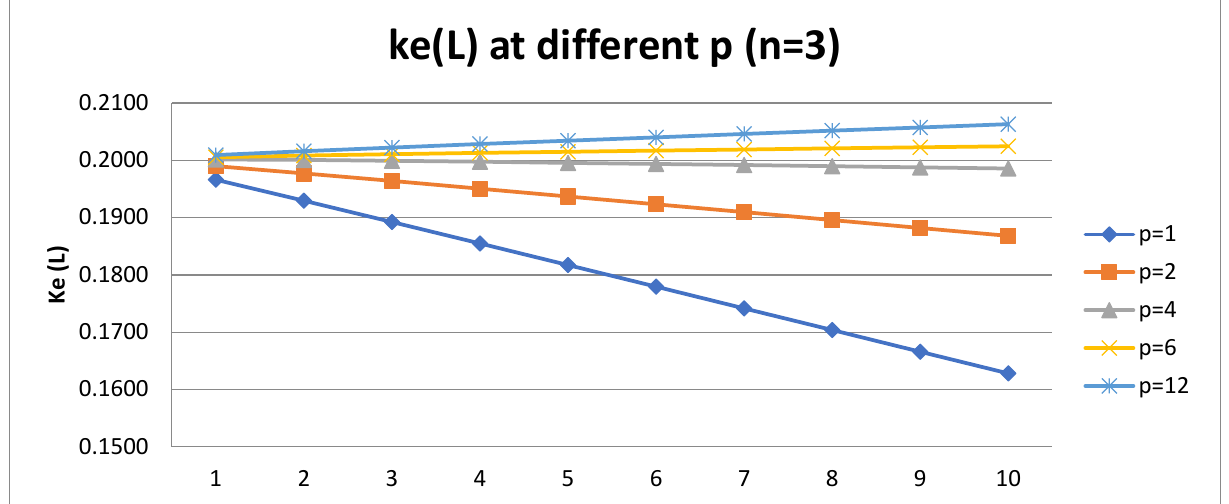
Figure 3. The dependence of the equity cost ( ke ) on the leverage level ( L ) of a three-year-old company for advance profit tax payments with frequencies of p = 1, 2, 4, 6 and 12.